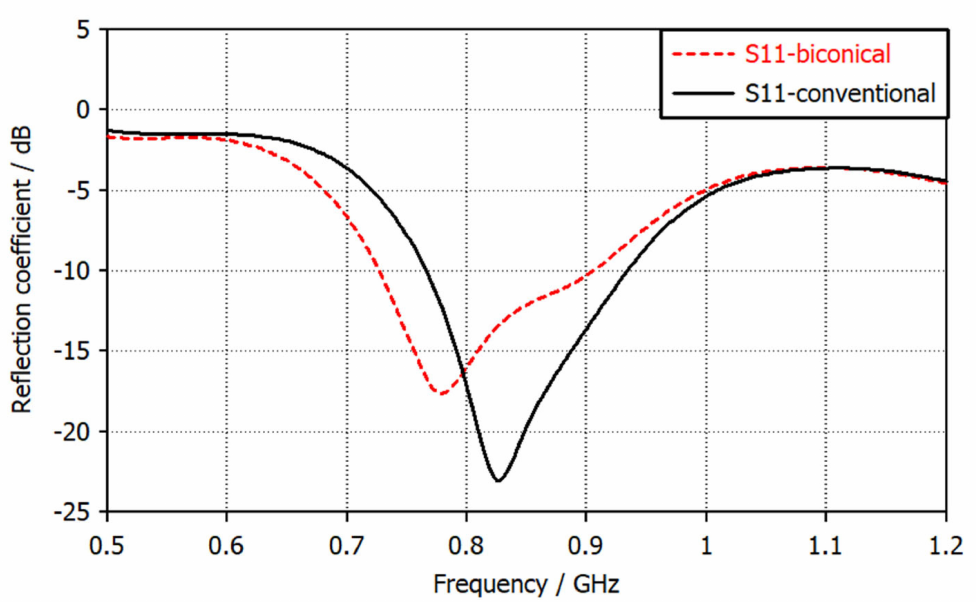
Figure 3. Reflection coefficient versus frequency for conventional and biconical dipole.